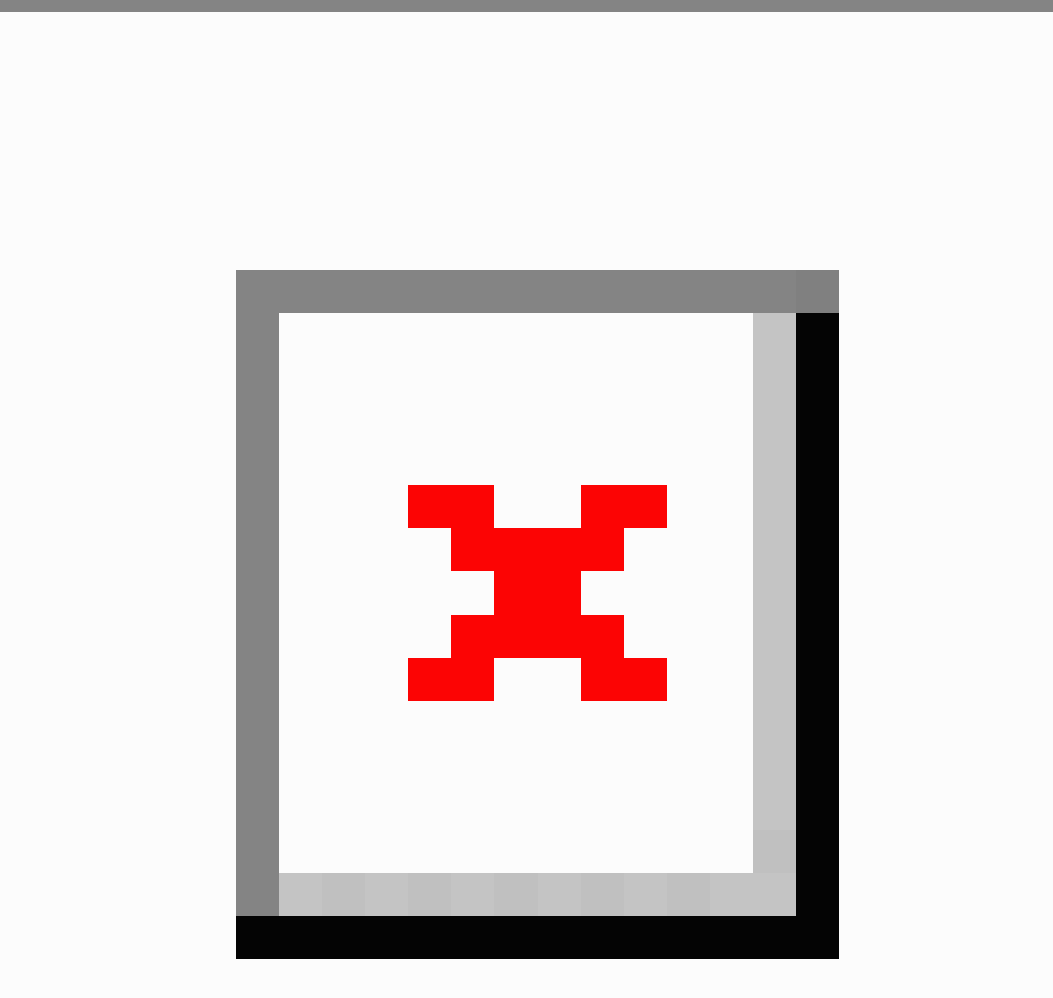
Percentage of users still active in the website throughout the 12 weeks. Site I= Information-based; Site II=Supportive; Site